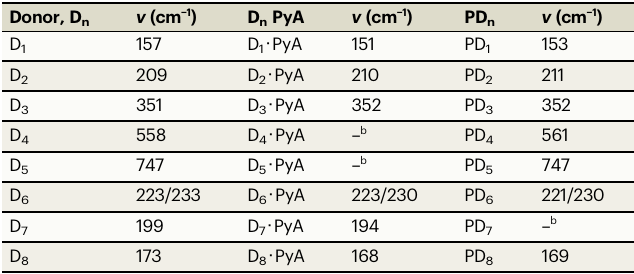
Table 1 | Experimental Raman frequencies a for D n , D n PyA, and